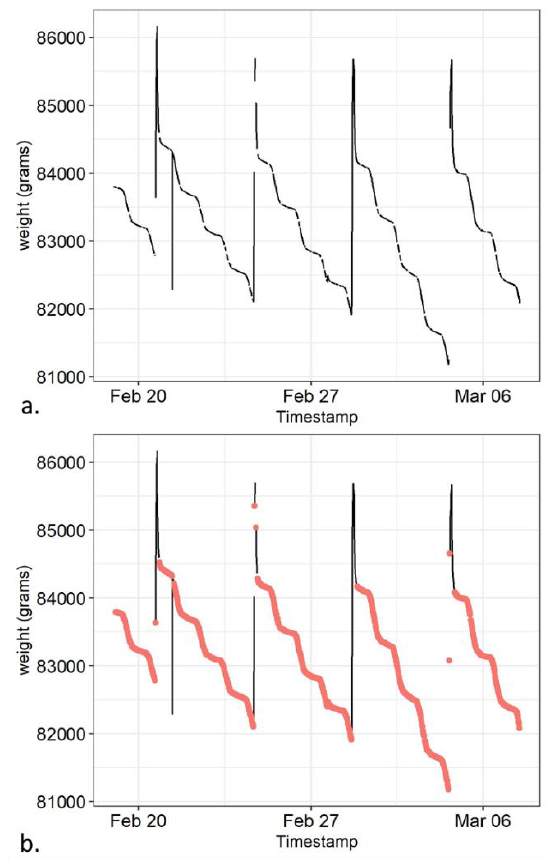
Figure 1. An example of raw load cell time series (a) and stage-1 pre-processed time series (b; data points retained after outlier removal is shown in red)